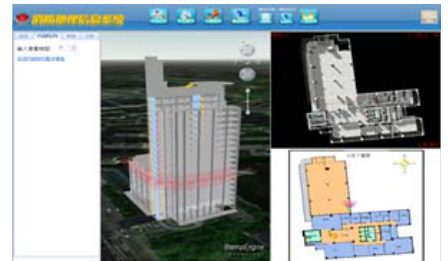
Figure 4. Three-dimensional performance in fire geographic information